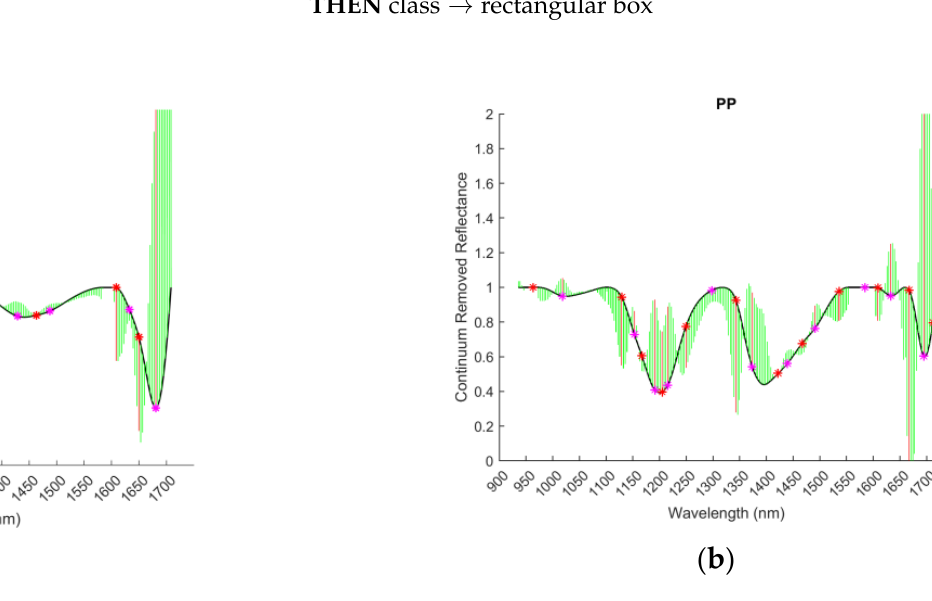
Figure 9. Continuum Removed Reflectance spectra (black line), calculated curvature values (green lines), maximum points with concave behavior (red dots) and minimum points with convex behavior (magenta dots) for ( a ) Polystyrene (PS); ( b ) Polypropylene (PP) [31].